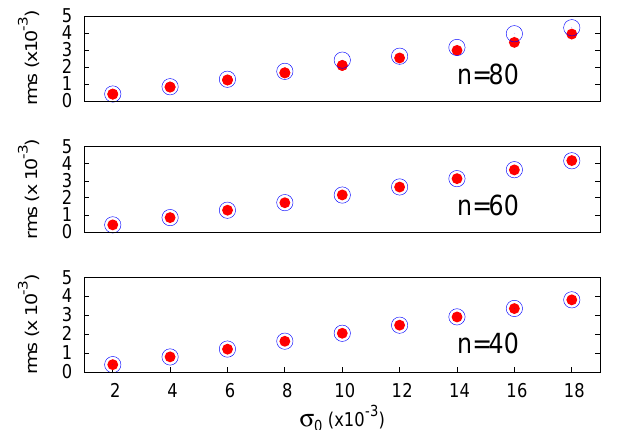
Fig. 1. Average root mean square error of the algorithms: EKF (full circles), EKF-AUS (empty circles) for systems with n = 40 , 60 , 80 degrees of freedom, as a function of σ 0 , the observation error stan- dard deviation. The average was performed over 1000 assimilation steps (50 time units) after a stabilization period of the same